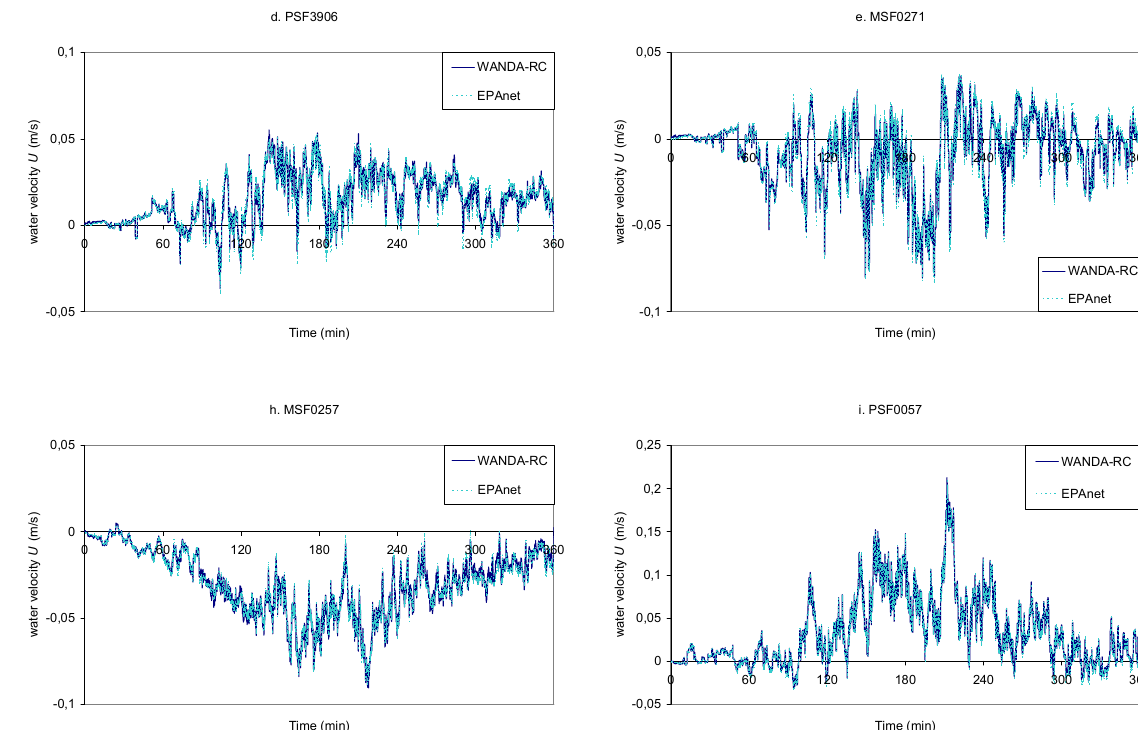
Figure 5: 5-minute detail of the three modelling approaches in pipe e (100 = 6:40 AM). 2